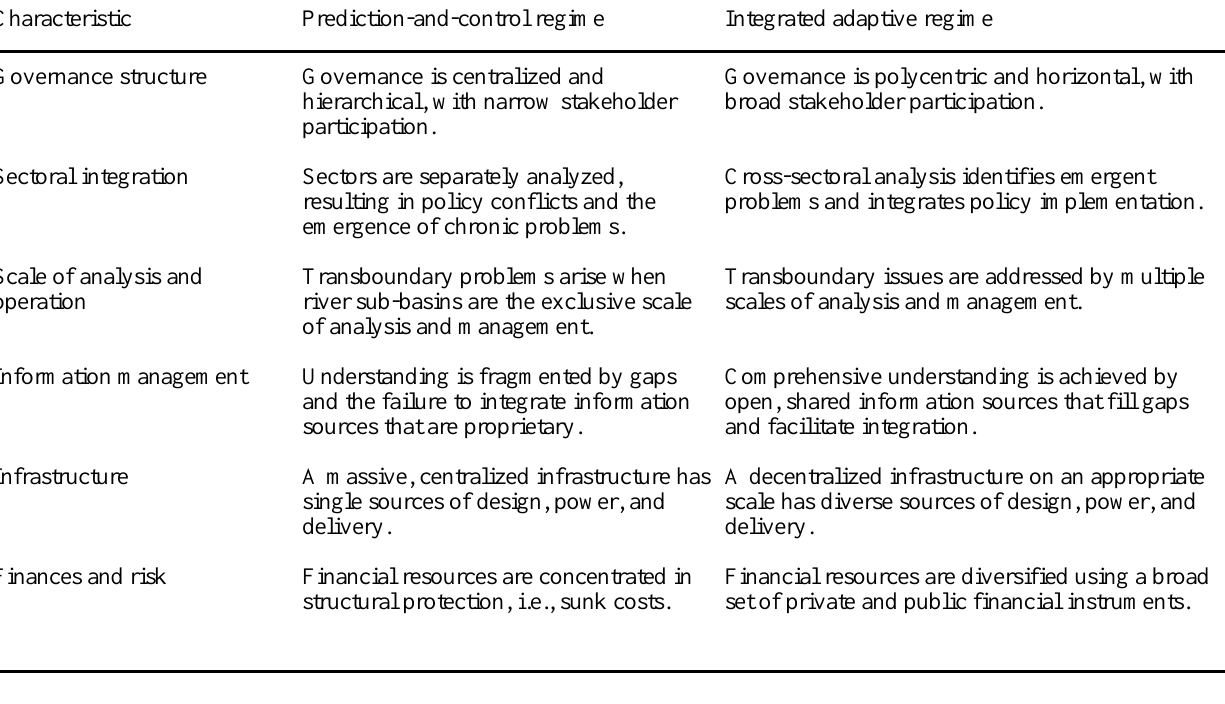
Table 1 . Ideal-typical characterizations of a prediction-and-control and an integrated adaptive water management